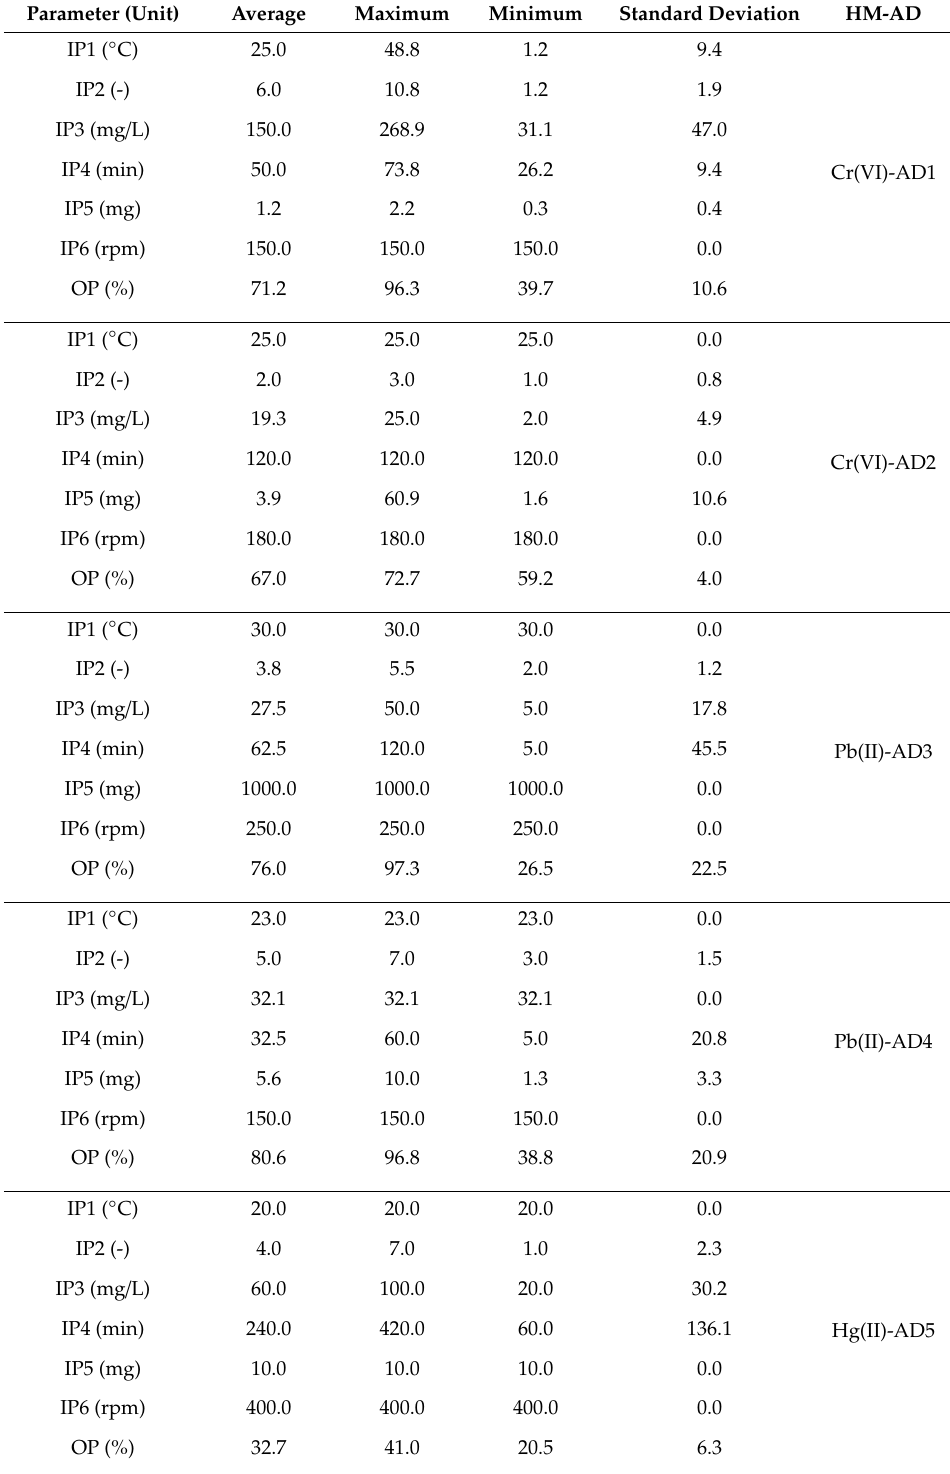
Table 2. Statistical presentation of the